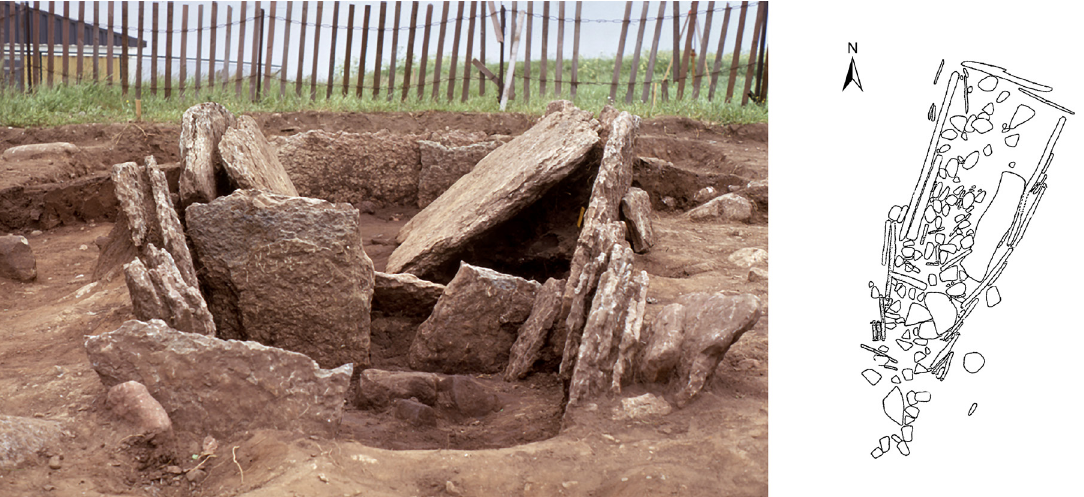
Figure 2. Photo and drawing of Falköping stad 5 during excavation. Photo by Ullberg, 1973, Falbygdens museum. Drawing based on Weiler (1977, p.